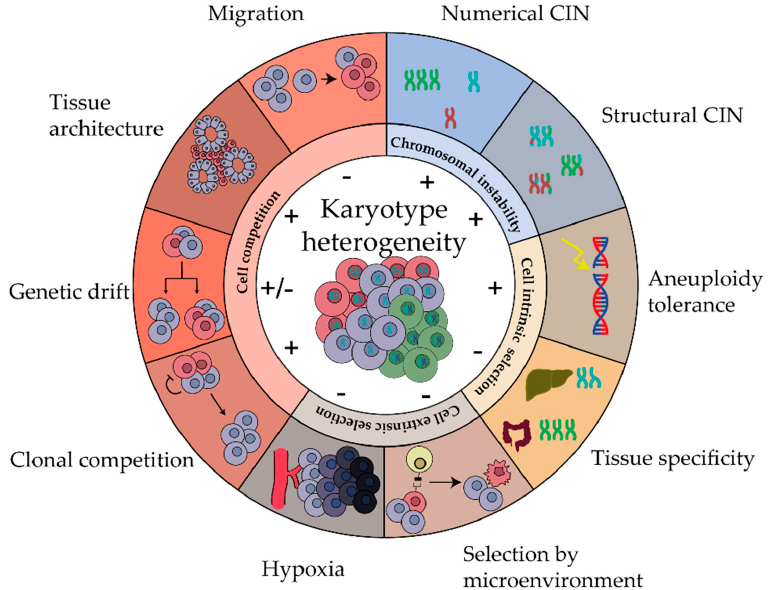
Figure 1. Biological processes and properties that shape karyotype heterogeneity. Karyotype heterogeneity is increased or decreased by chromosomal instability, cell intrinsic and extrinsic selection and cell competition.